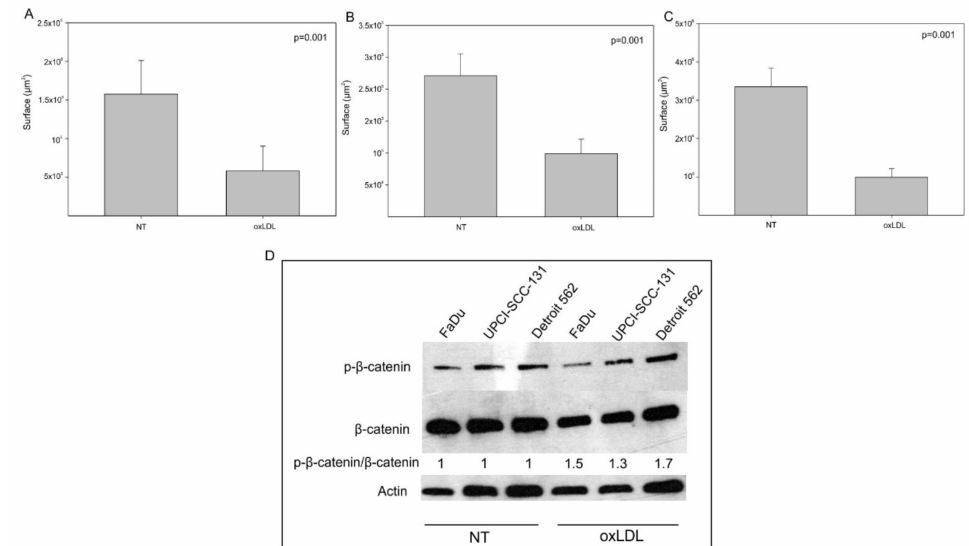
Figure 4. Decreased migration of HNC cell lines under oxLDL exposure. ( A – C ) Surface area covered by cells decreased significantly after oxLDL exposure in FaDu cells ( t -test, p = 0.001, n = 6), Detroit 562 cells ( t -test, p = 0.001, n = 6) and UPCI- SCC-131 cells ( t -test, p = 0.001, n = 6), respectively (mean ± SD; o: datapoint) (NT: cells without oxLDL). ( D ) Representative Western blotting of p- β -catenin and β -catenin in HNC cell lines exposed or not exposed to oxLDL for 6 h. Actin is presented as the loading control. Fold change of p- β -catenin in untreated and treated cells.